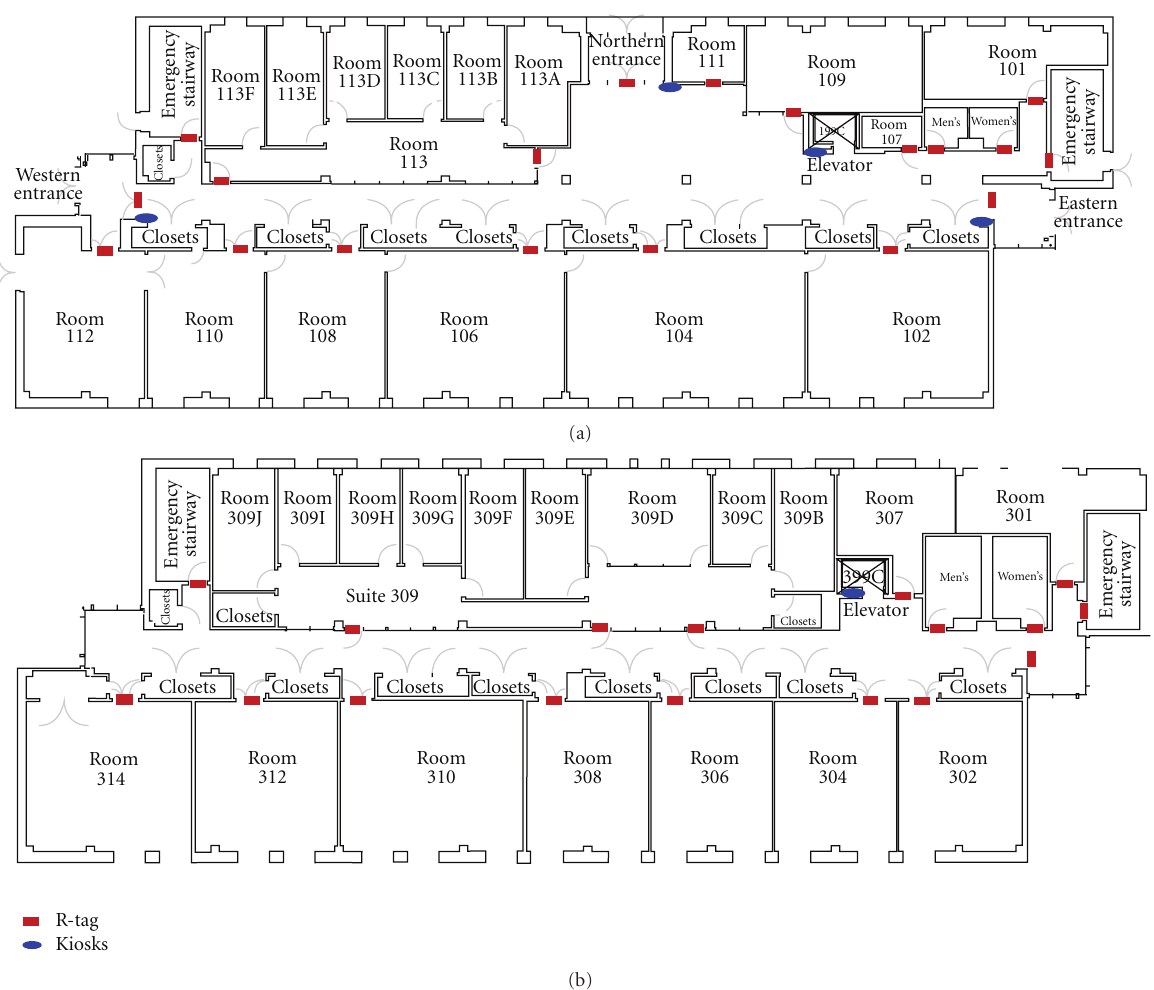
Figure 6: (a) 1st Floor structure of Knowles Engineering Building and (b) 3rd Floor structure of Knowles Engineering